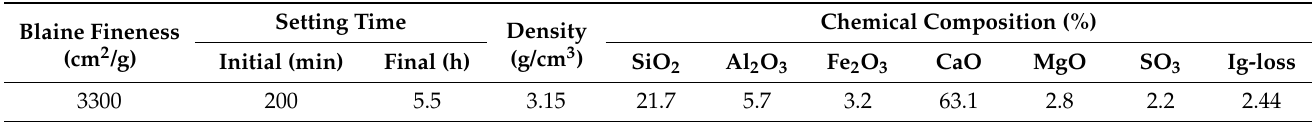
Table 2. Physical properties and chemical composition of ordinary Portland